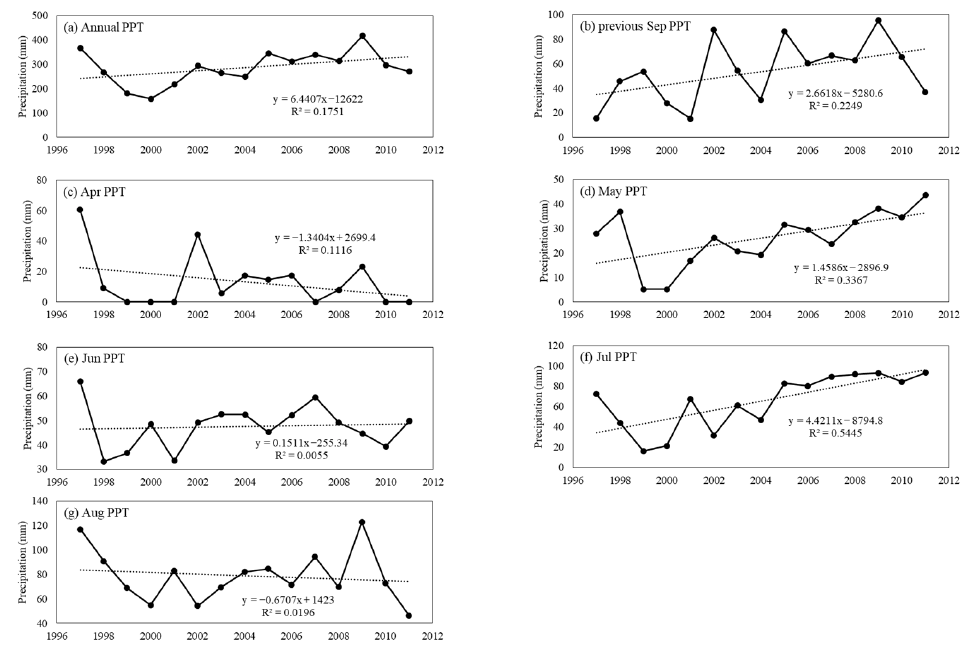
Figure A2. Trends of annual and monthly effective precipitation during 1997–2011. ( a ) Annual precipitation; ( b ) previous September precipitation; ( c ) April precipitation; ( d ) May precipitation; ( e ) June precipitation; ( f ) July precipitation; ( g ) August precipitation.